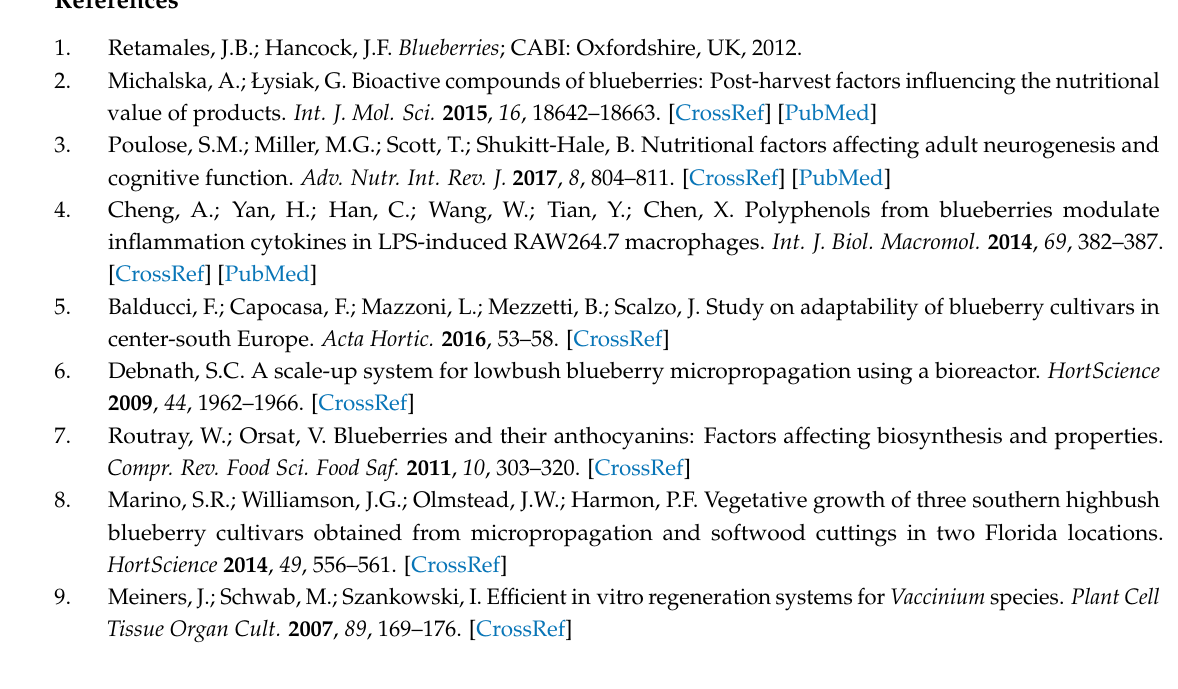
s1, Table S1: Results of the two-way ANOVA of experiment 1 studying the influence of cytokinin type and concentration on survival (%), shoot formation (%), number of shoots (nº), length of shoot (mm), and number of leaves (nº) on initial in vitro shoot culture of ‘Delite’ rabbiteye blueberry, Table S2: Number of explants evaluated after contamination in experiment 1 in each of the treatments (cytokinin type by concentration) on initial in vitro shoot culture of ‘Delite’ rabbiteye